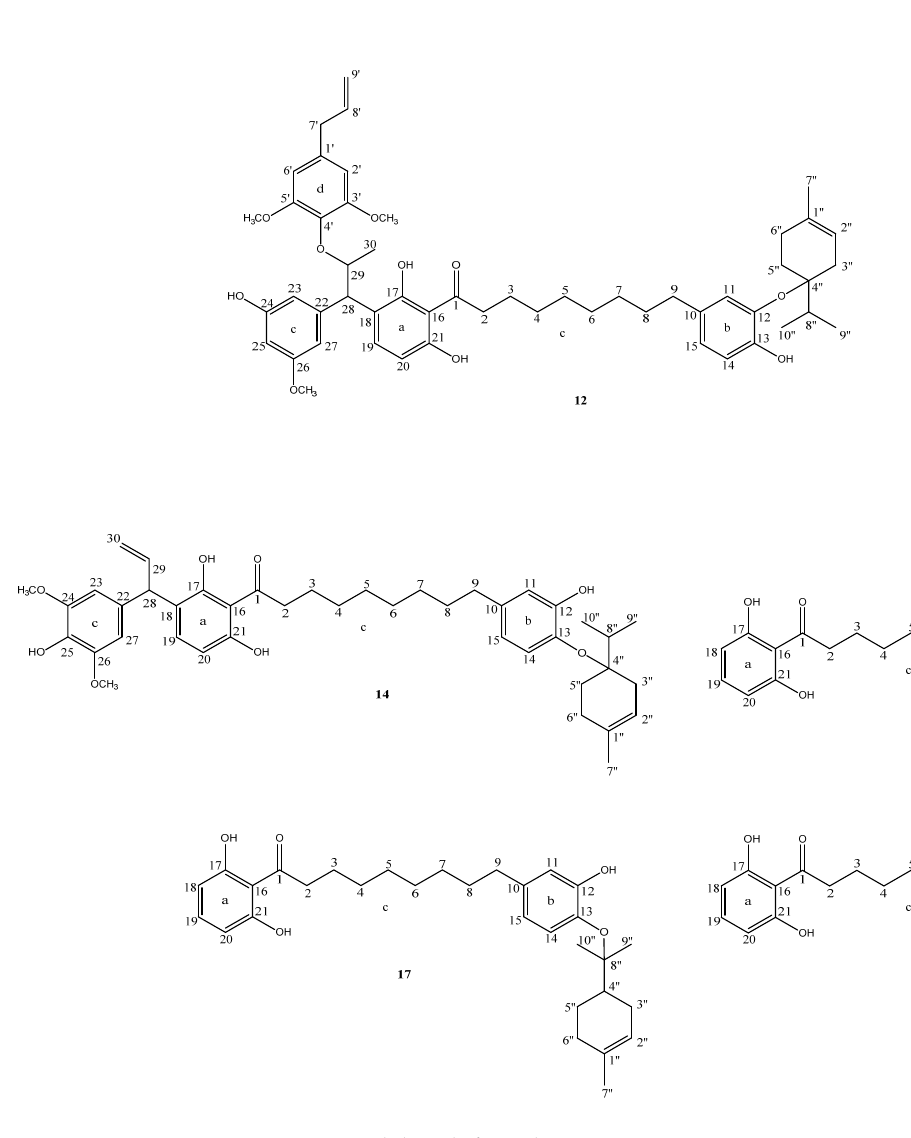
Figure 1. Acylphenols from the genus Myristica